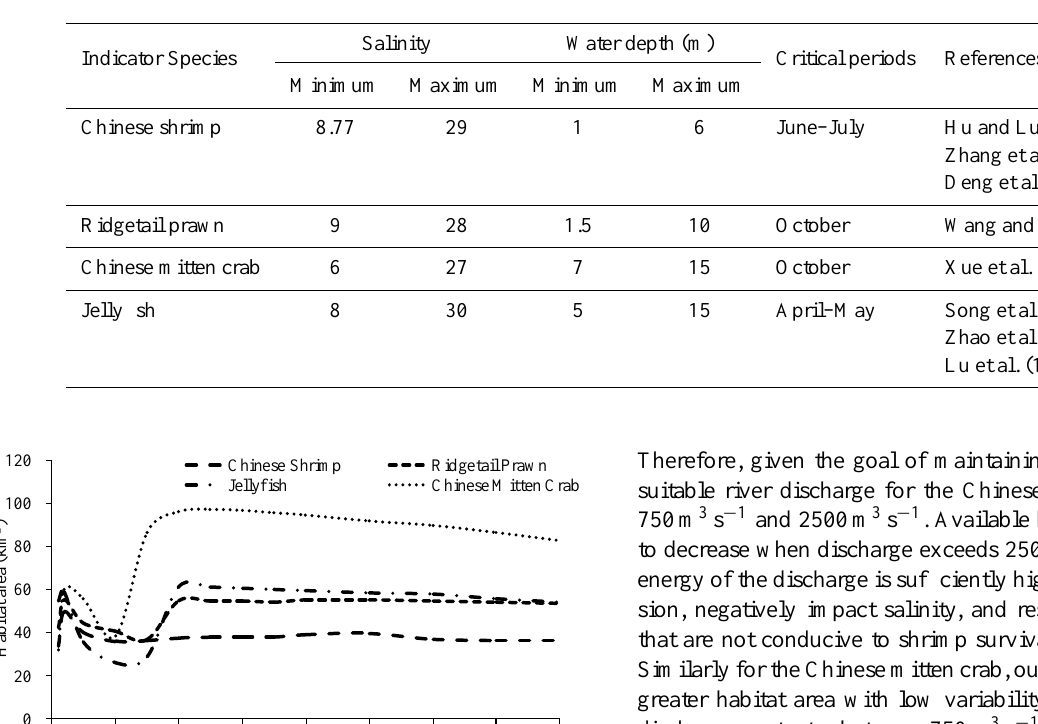
Table 1. Habitat requirements for four key indicator species in the Yellow River estuary.